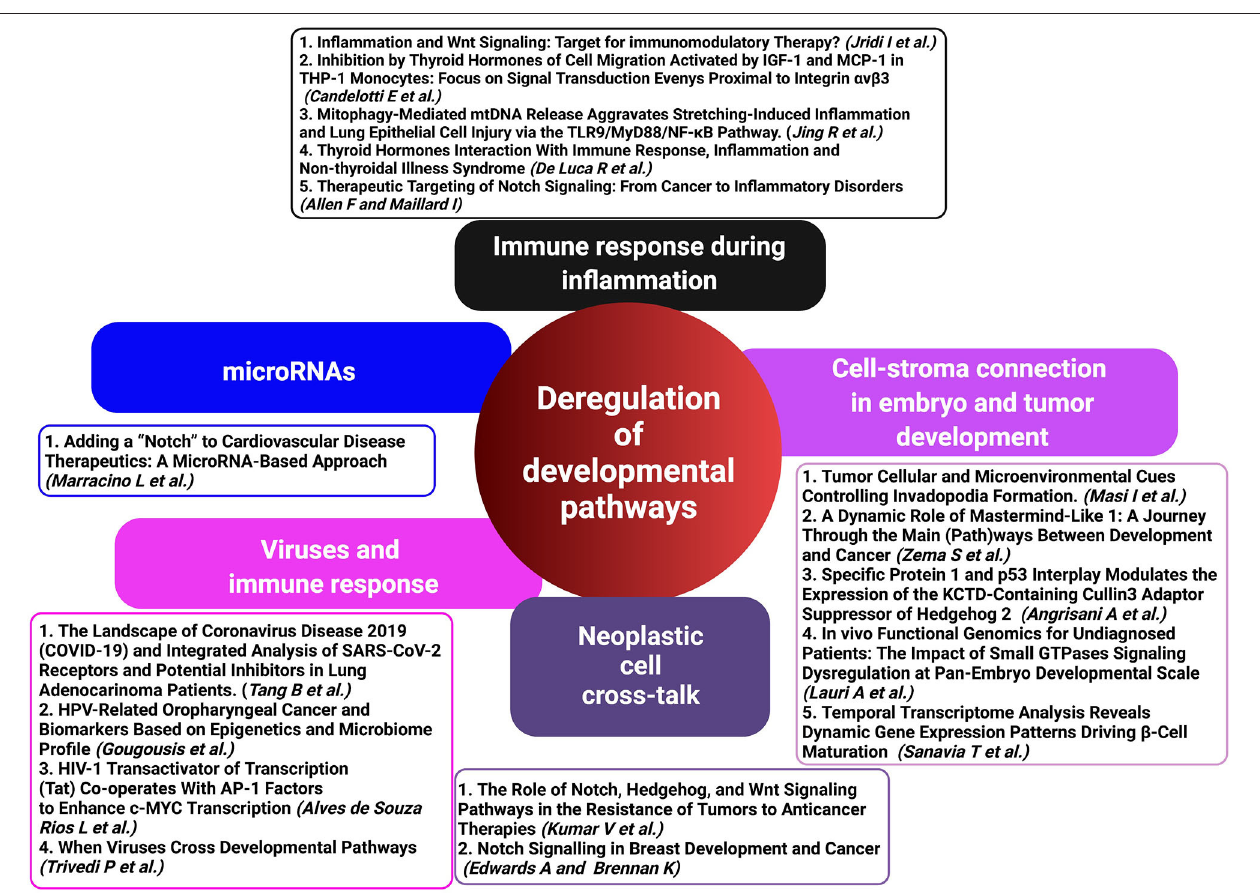
FIGURE 1 | Deregulated developmental pathways (HH, Notch, and WNT) in inflammation, immune response, and cancer development represent critical crossroads for therapeutic intervention. A schematic representation of contributed articles to our special issue highlights the potential of targeting deregulated developmental pathways as a therapeutic approach in virus-associated diseases and malignancies (created with